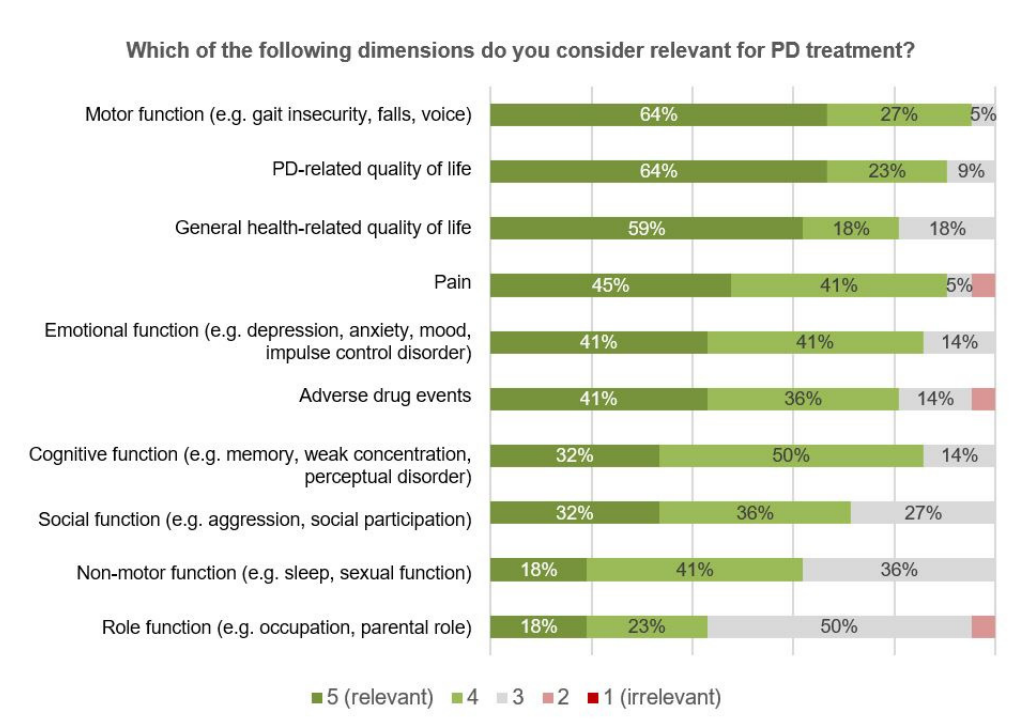
Figure 4. Survey results—relevant dimensions for PD treatment from physicians’ perspectives ( n = 21).